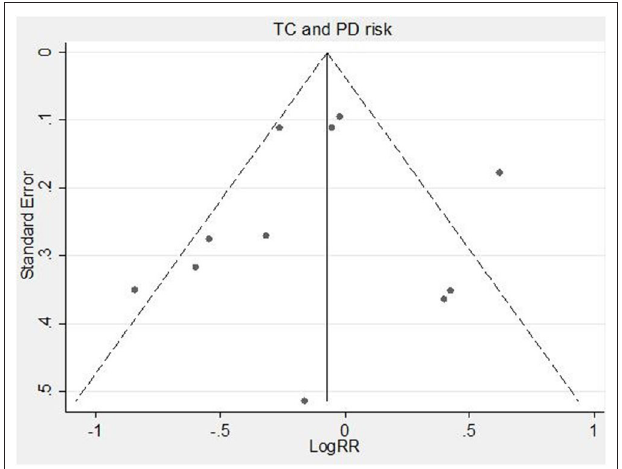
FIGURE 3 | Funnel plot of serum TC levels and risk of PD. RR, relative risk; TC, total cholesterol; PD, Parkinson’s disease.